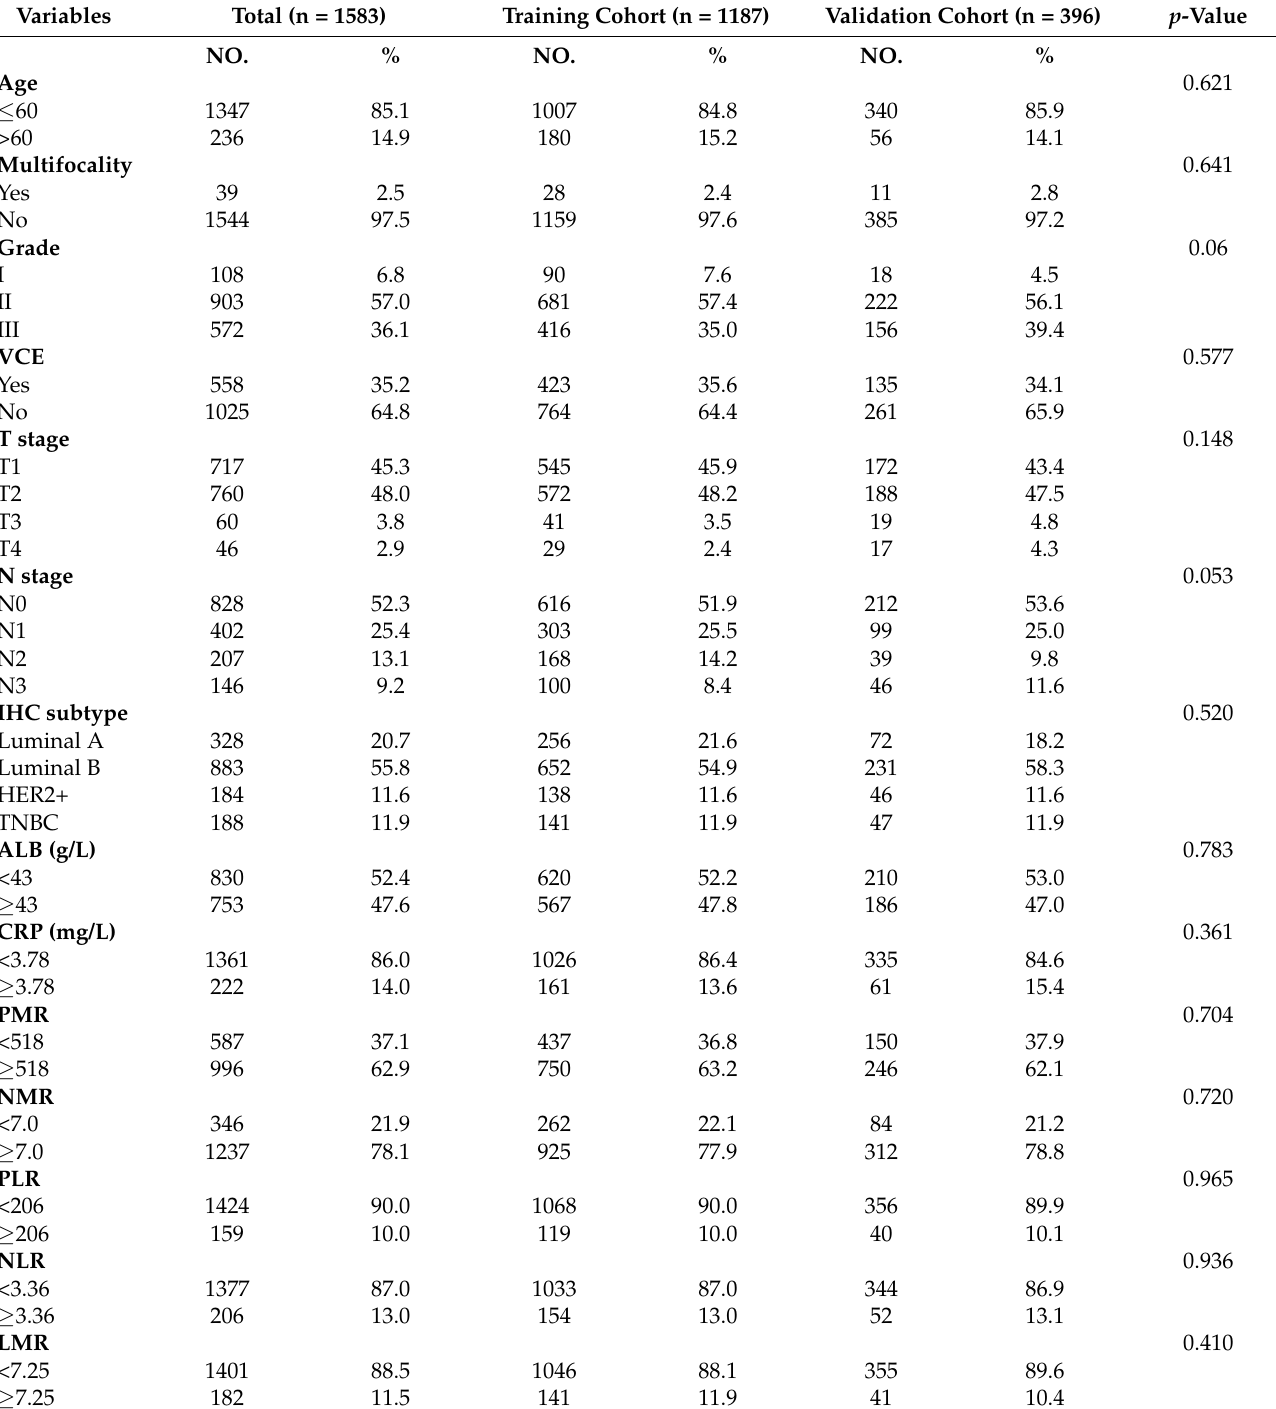
Table 1. Patient and tumor characteristics in the training cohort and external validation